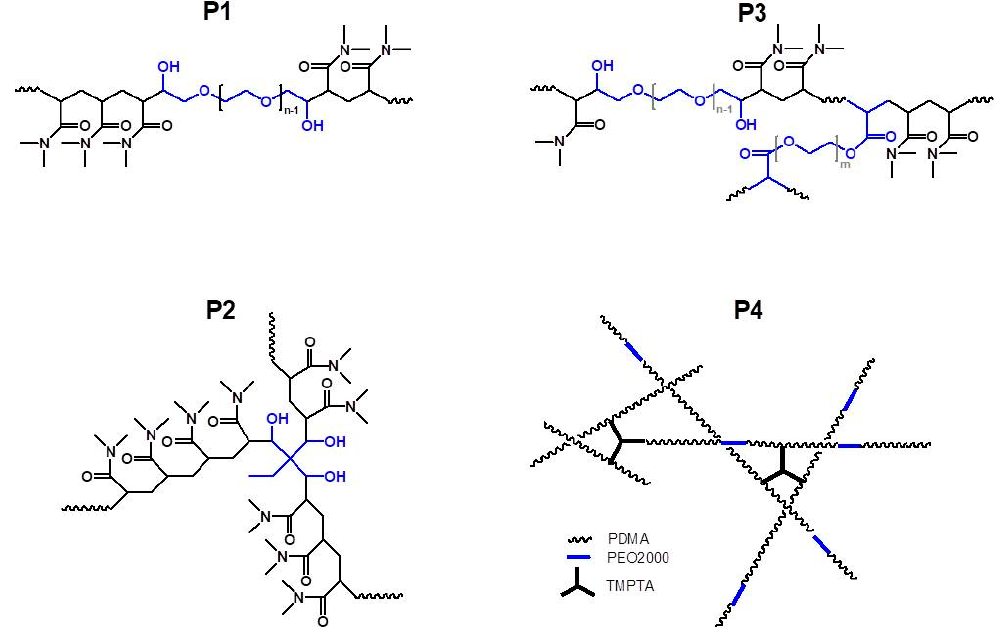
Figure 2. Schematic presentation of the structures of obtained copolymers P1–P4.